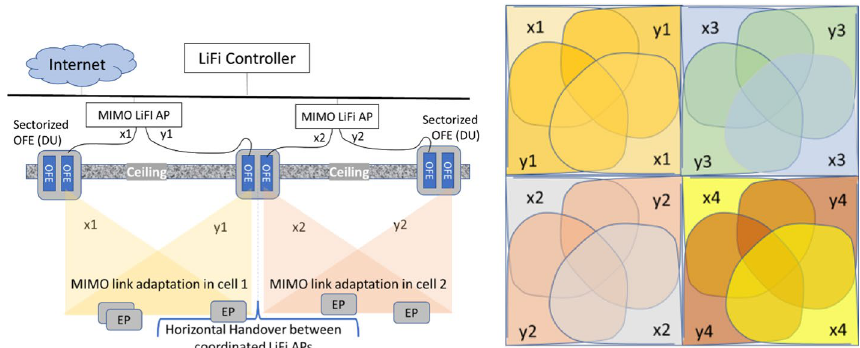
Fig. 13 LiFi cell layout that places cell boundaries along collimated sectors. Horizontal handovers take place on a well-defined line, while soft MIMO link adaptation takes place in areas in between APs. Left: cross section. Right: top view of MIMO channels x,y in cell 1,